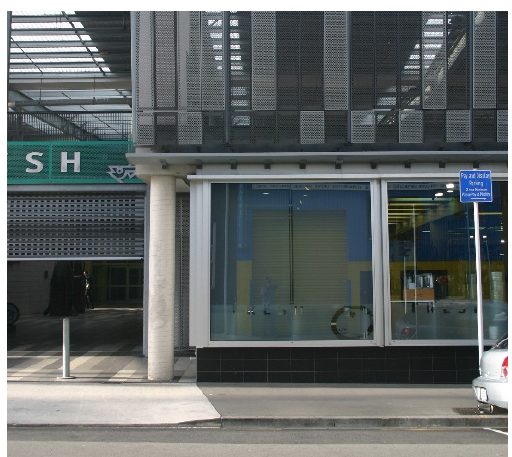
Figure 2. Detail from the street facade of the building of a prominent food retailer, the second best liked building in the street.